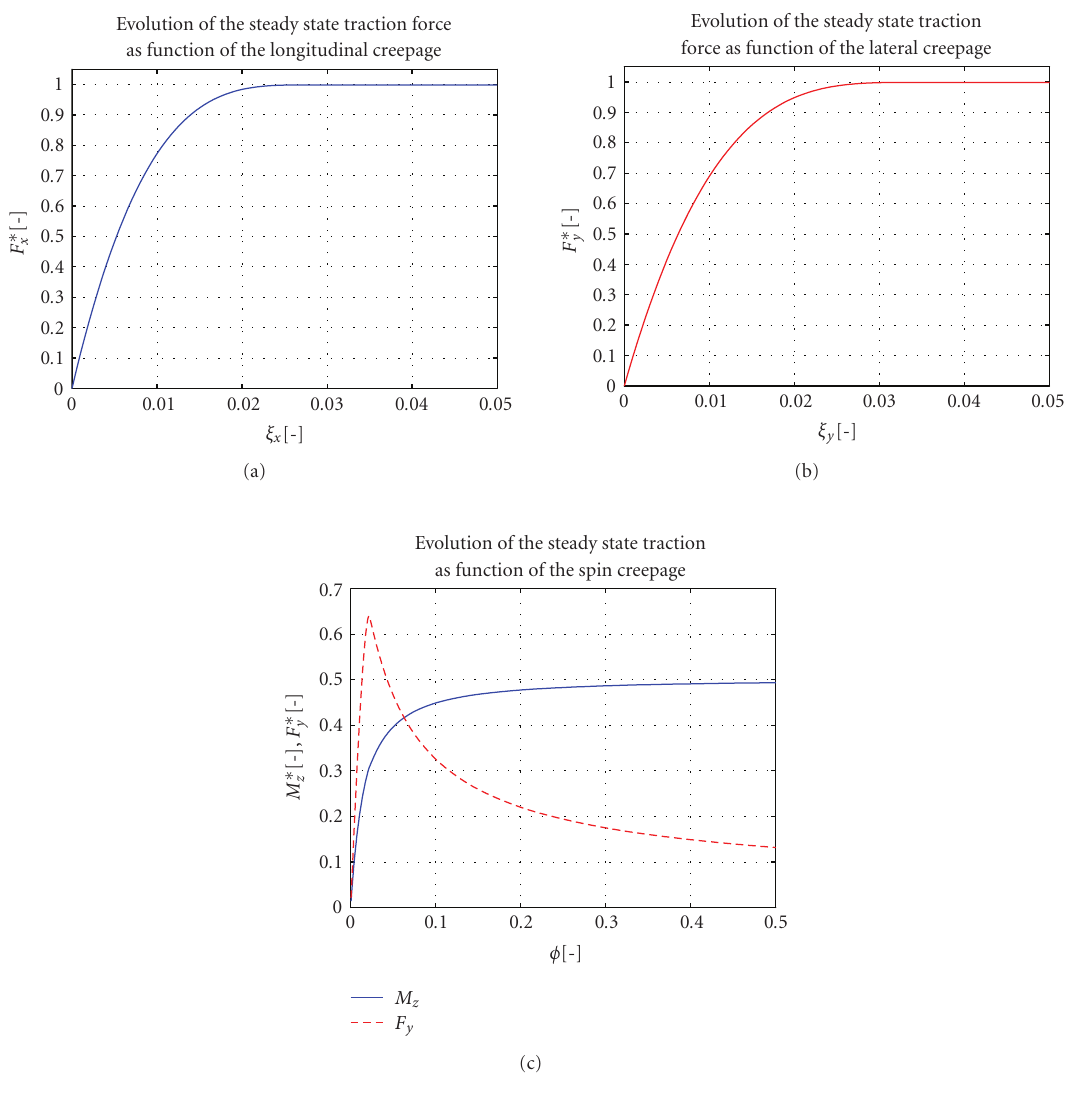
Figure 13: The evolution of the steady-state traction as function of the